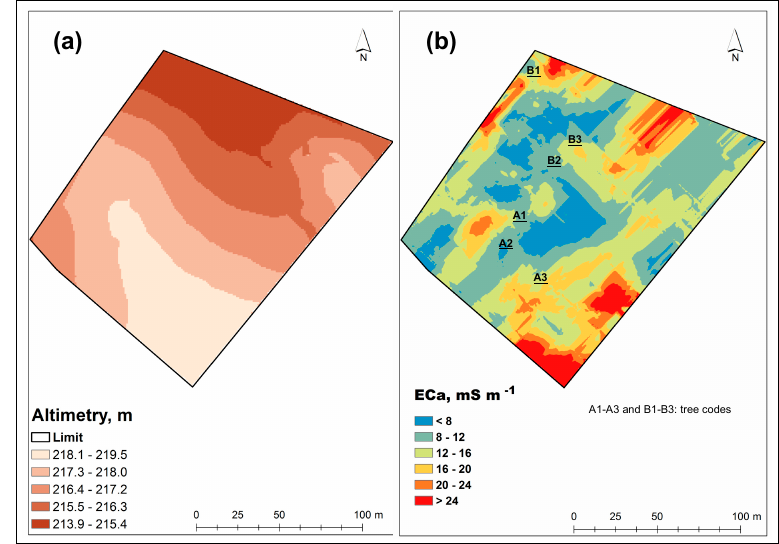
Figure 11. Altimetry map ( a ) and apparent soil electrical conductivity map ( b ) of the experimental field.